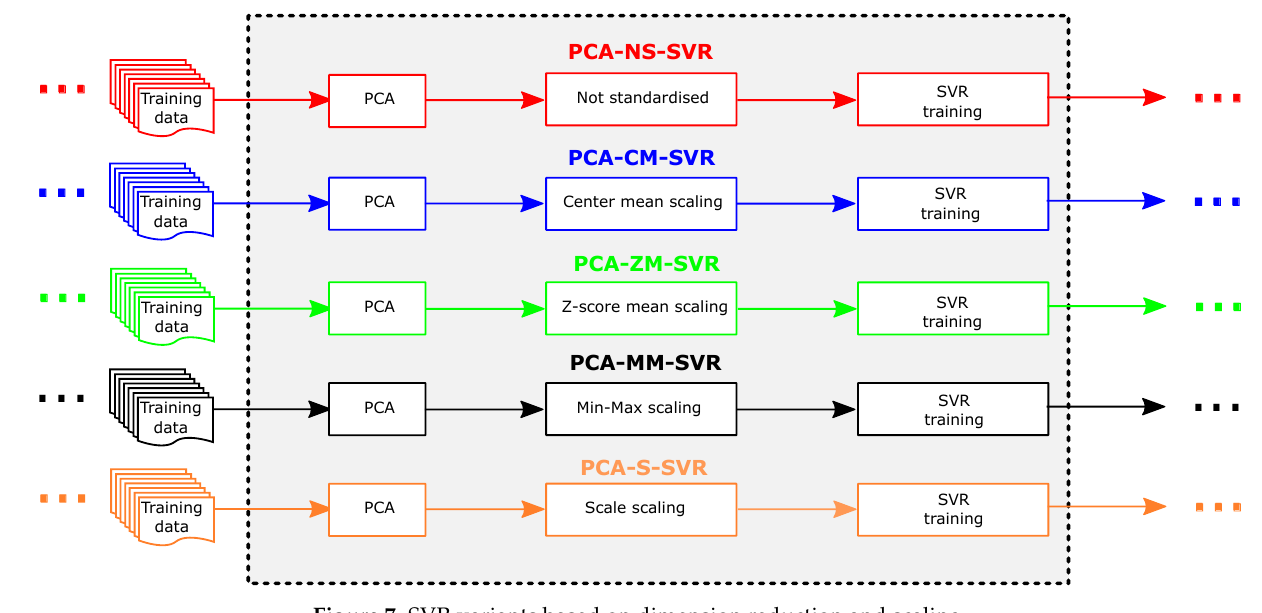
Figure 7. SVR variants based on dimension reduction and scaling.